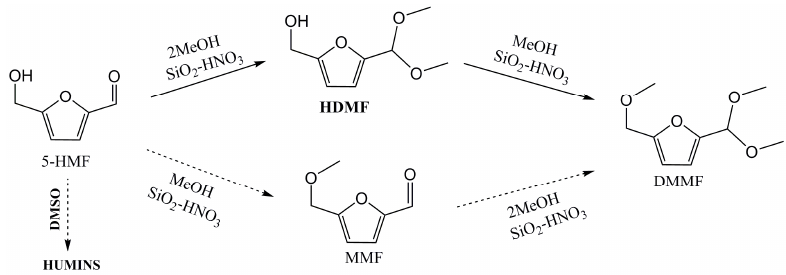
Scheme 1. Acetalization of 5 ‐ HMF in methanol using SiO 2 ‐ HNO 3 .